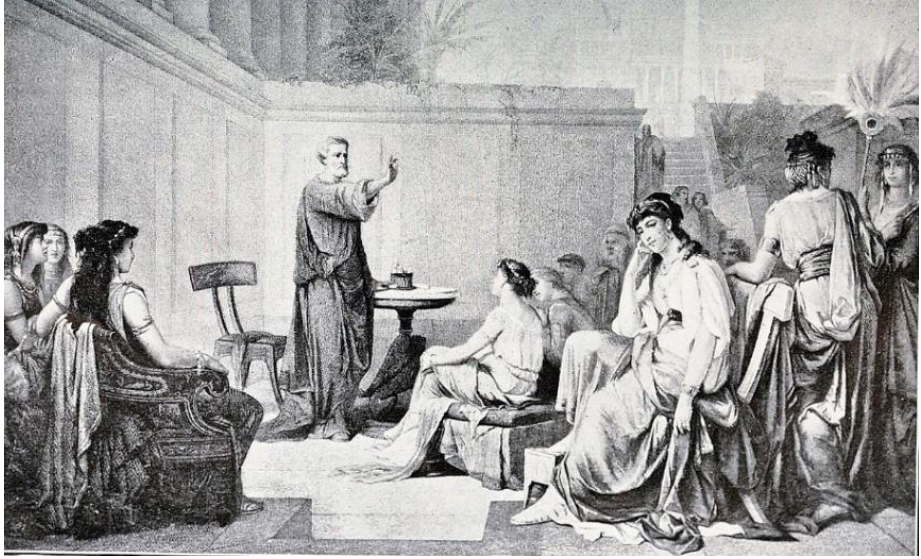
Figure 4. Illustration from 1913 showing Pythagoras teaching a class of women [40]. Finally, a lot of evidence indicates that Pythagoras was charismatic and quickly ac- quired great political influence in his new environment. Moreover, the concept of a spherical world is also attributed to Pythagoras. His disciple Parmenides of Elea (ca 540–460 BC) stip- ulated five zones on the surface of this spherical world (one torrid, two temperate, and two frigid) and stated that the central torrid zone was uninhabitable because of the heat from the direct rays of the Sun [44]. Not all Greek intellectuals shared this belief. Nonetheless, the explanations of several meteorological phenomena were based on Pythagoras’